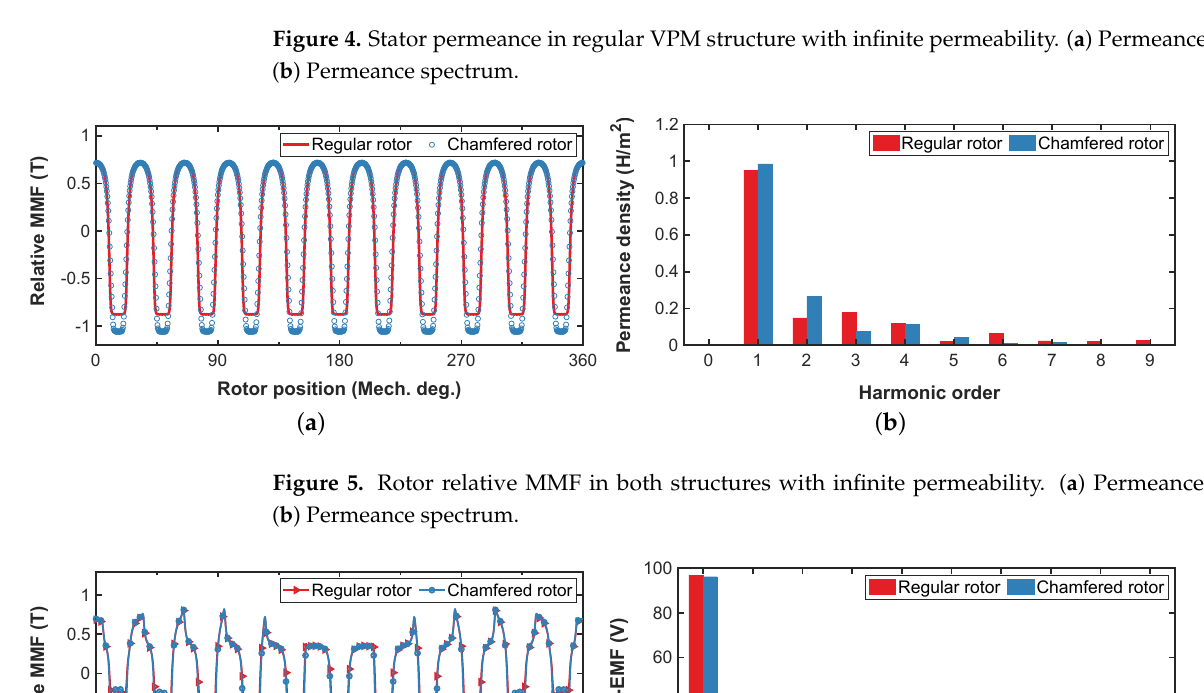
Rotor position (Mech. deg.)